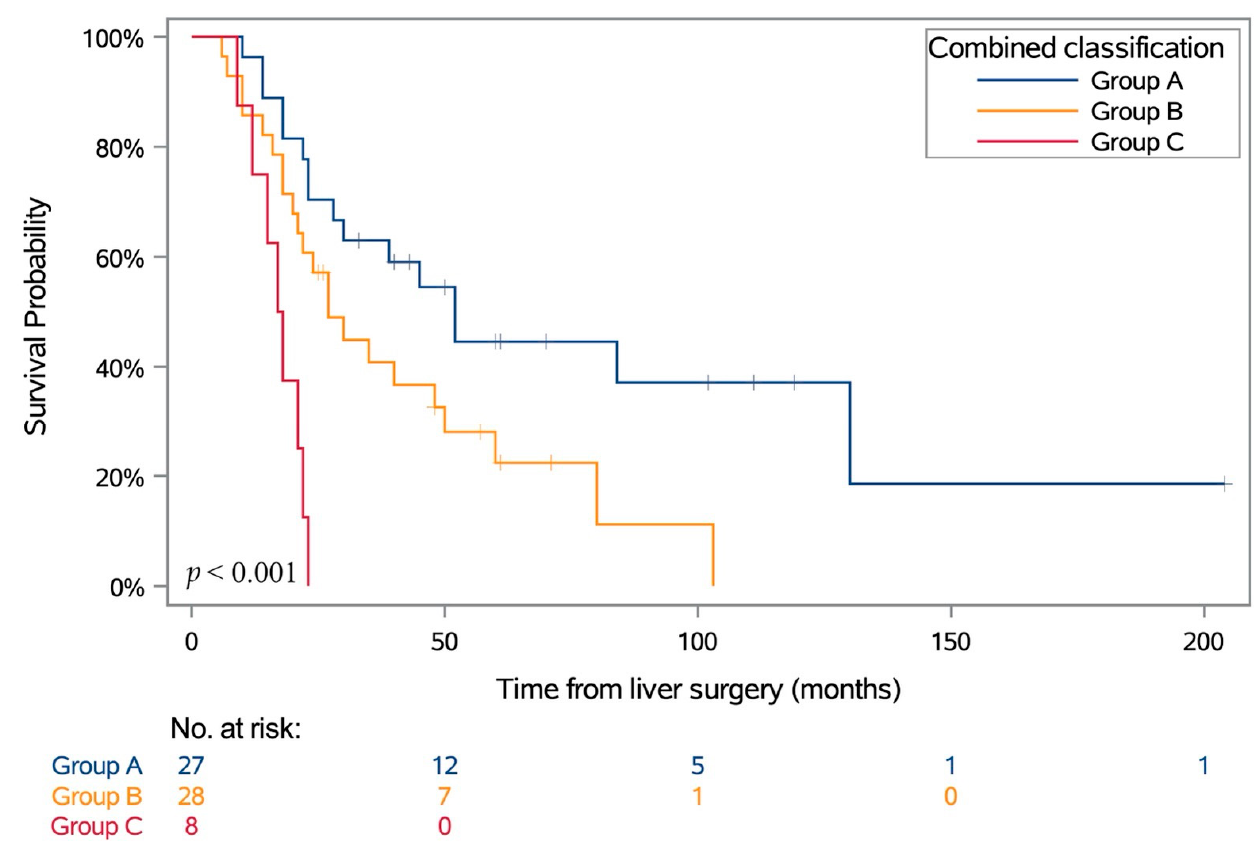
Figure 3. OS according to combined classification based on genetic risk and MRI melanin quantification. p values were calculated using log-rank test. Group A refers to D3/8nl, D3/8g or M3/8nl; Group B refers to M3/8g abnormalities and mT1s ≤ 1.1; Group C refers to M3/8g abnormalities and mT1s > 1.1.